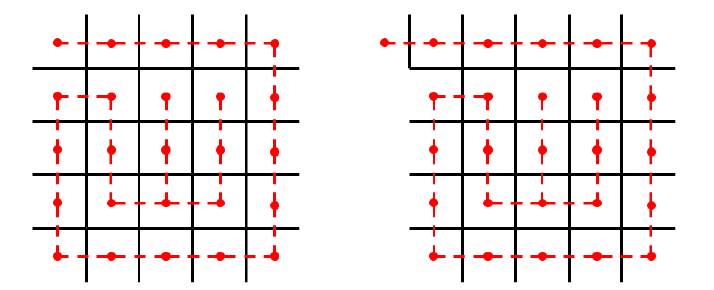
Figure 11 . An example of gauge (cid:12)xing: we do the gauge (cid:12)xing by taking the maximal tree of dual scalars to remove the redundancy. The left (cid:12)gure corresponds to the gauge (cid:12)xing of operators ^ A (or (cid:25) ) in the trivial center algebra of our model with square region of size n = 3, while the right (cid:12)gure corresponds to the gauge (cid:12)xing of electric (cid:12)elds in the trivial center algebra of Casini’s model [20] with square region of size n = 5. In the left (cid:12)gure, the solid links correspond to the operators ^ A (or (cid:25) ), while the red dots are the corresponding dual scalar operators ^ (cid:31) (or _ (cid:31) ). The red dashed lines form a maximal tree of scalars. We remove the redundancy by removing the solid links which are not cut by red dashed lines and keep the ones which are cut by red dashed lines. In this way, we get the left (cid:12)gure of (cid:12)gure 9. In the right (cid:12)gure, the solid links mean the electric (cid:12)elds, while the red dots are the corresponding dual scalar (cid:12)elds. We do the gauge (cid:12)xing in the same way. We can see that the scalar operators ^ (cid:31) (or _ (cid:31) ) in the left (cid:12)gure take the same places as the